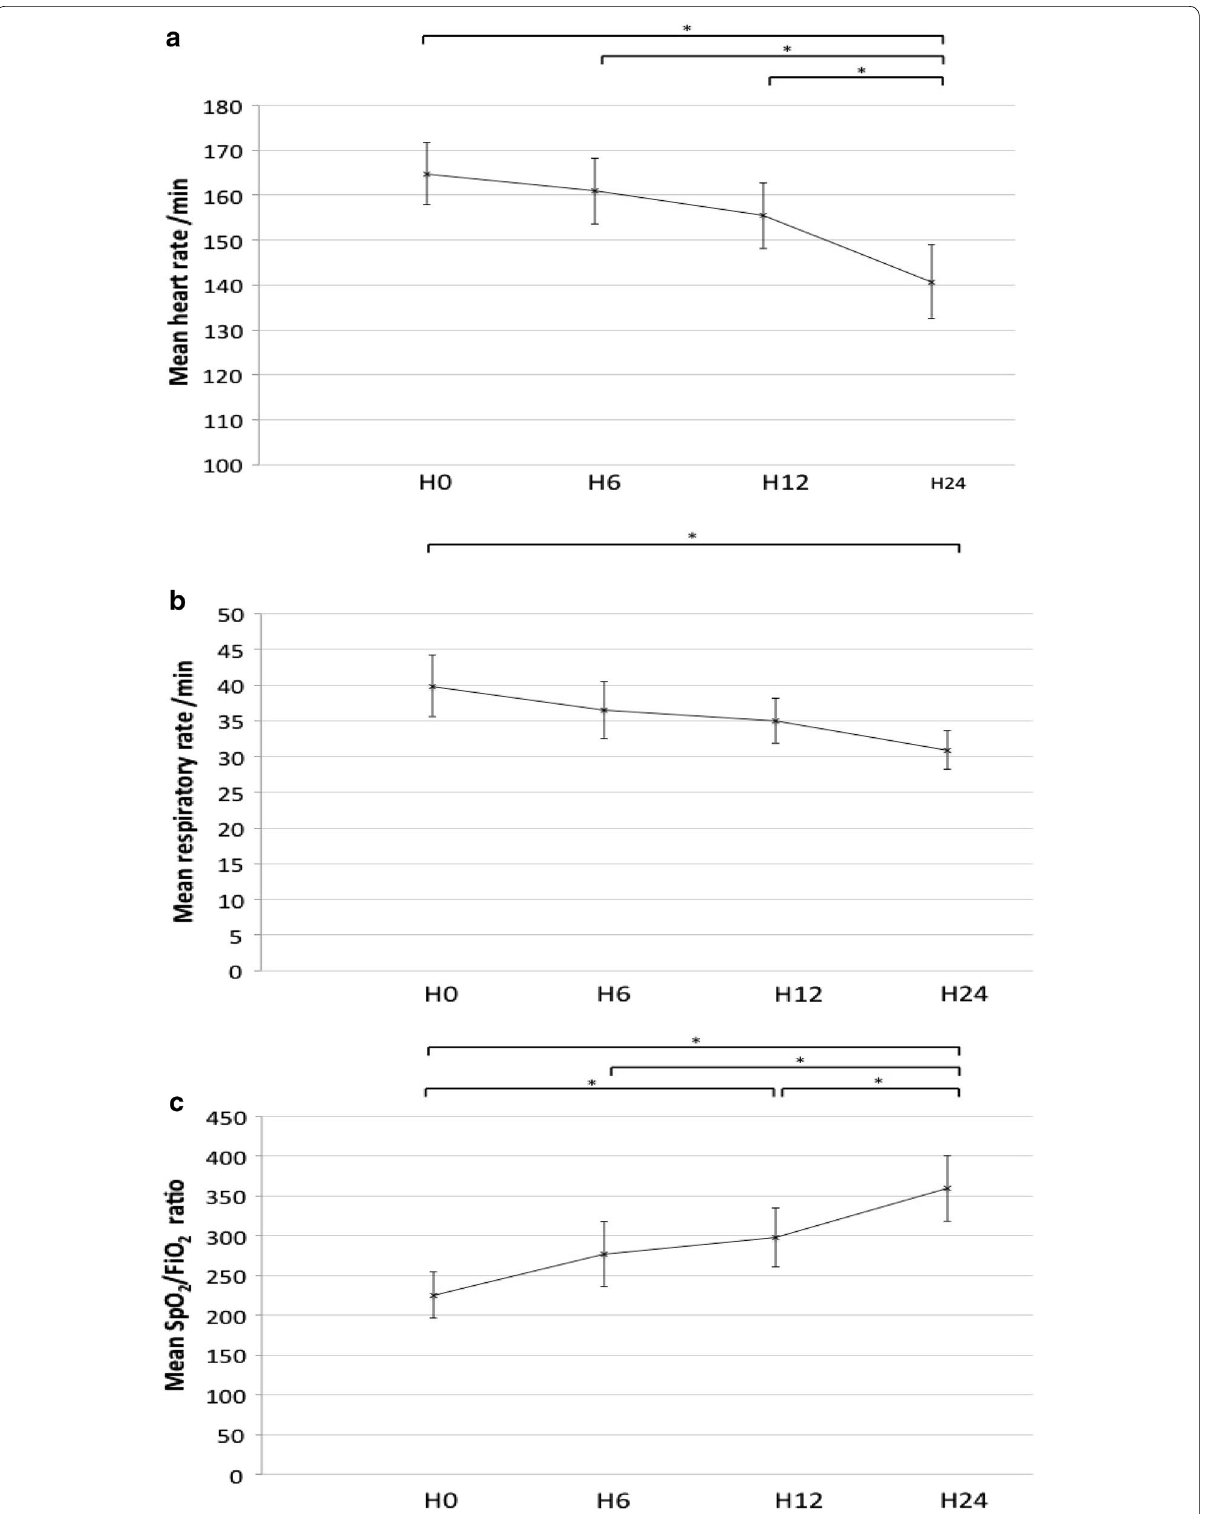
Fig. 3 Change of heart rate ( a ), respiratory rate ( b ), and SpO 2 /FiO 2 ratio ( c ) during the first 24 h in 38 children with status asthmaticus treated by nasal high flow. Heart rate, respiratory rate, and SpO 2 /FiO 2 ratio significantly change over time according to the repeated-measures analysis of vari- ance (ANOVA). *Significant difference with pairwise post hoc analysis ( p < 0.01). Bars indicate 95% confidence intervals. H